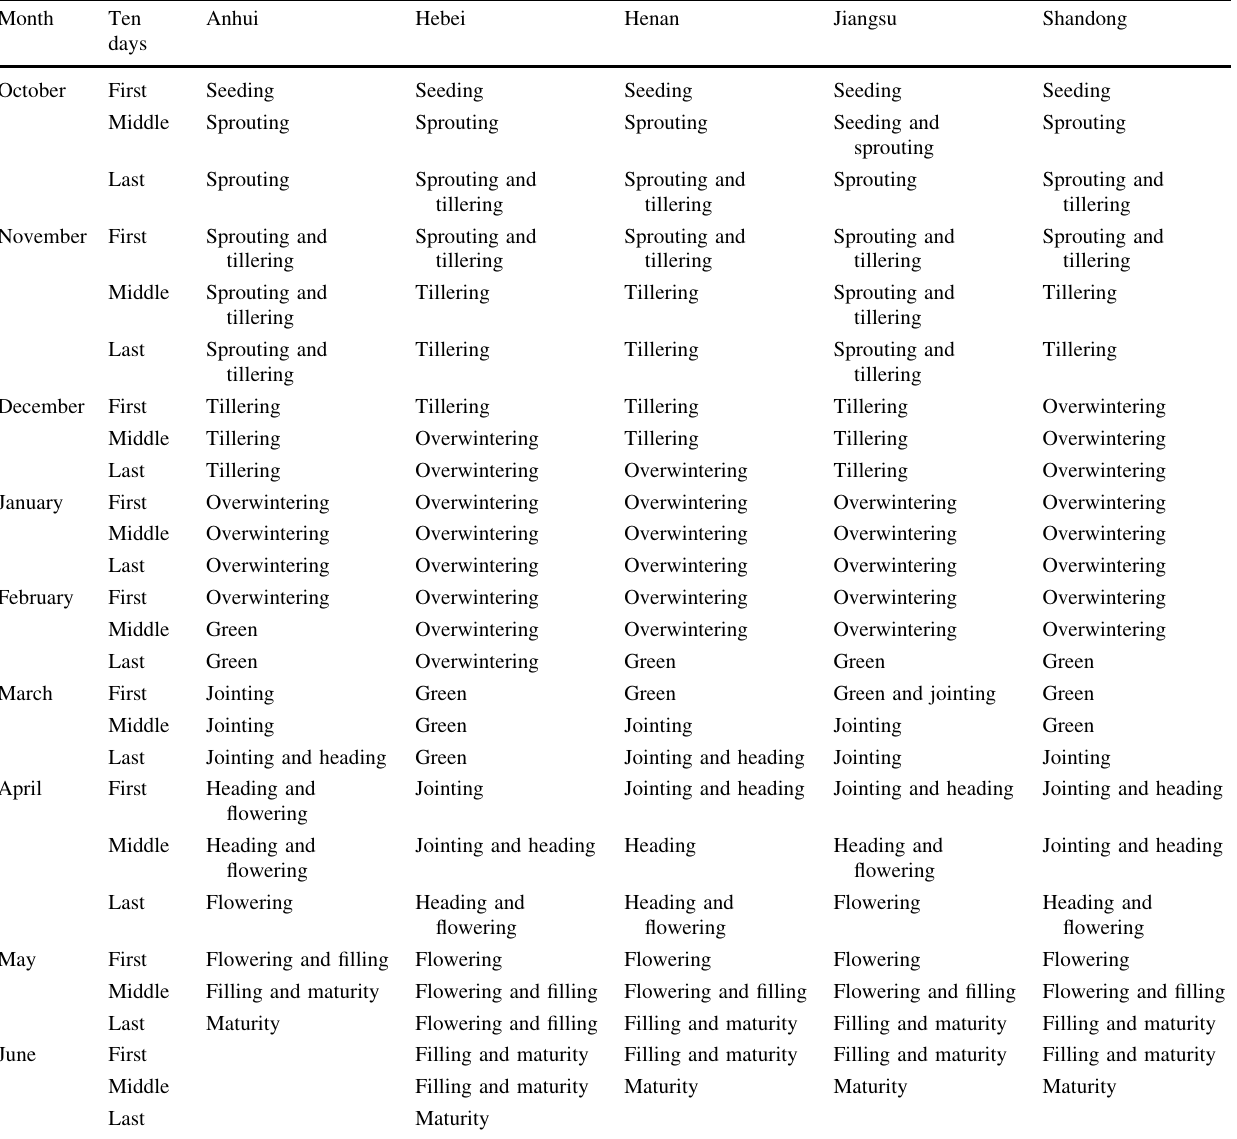
Table 1 Growing and developing periods for winter wheat in five